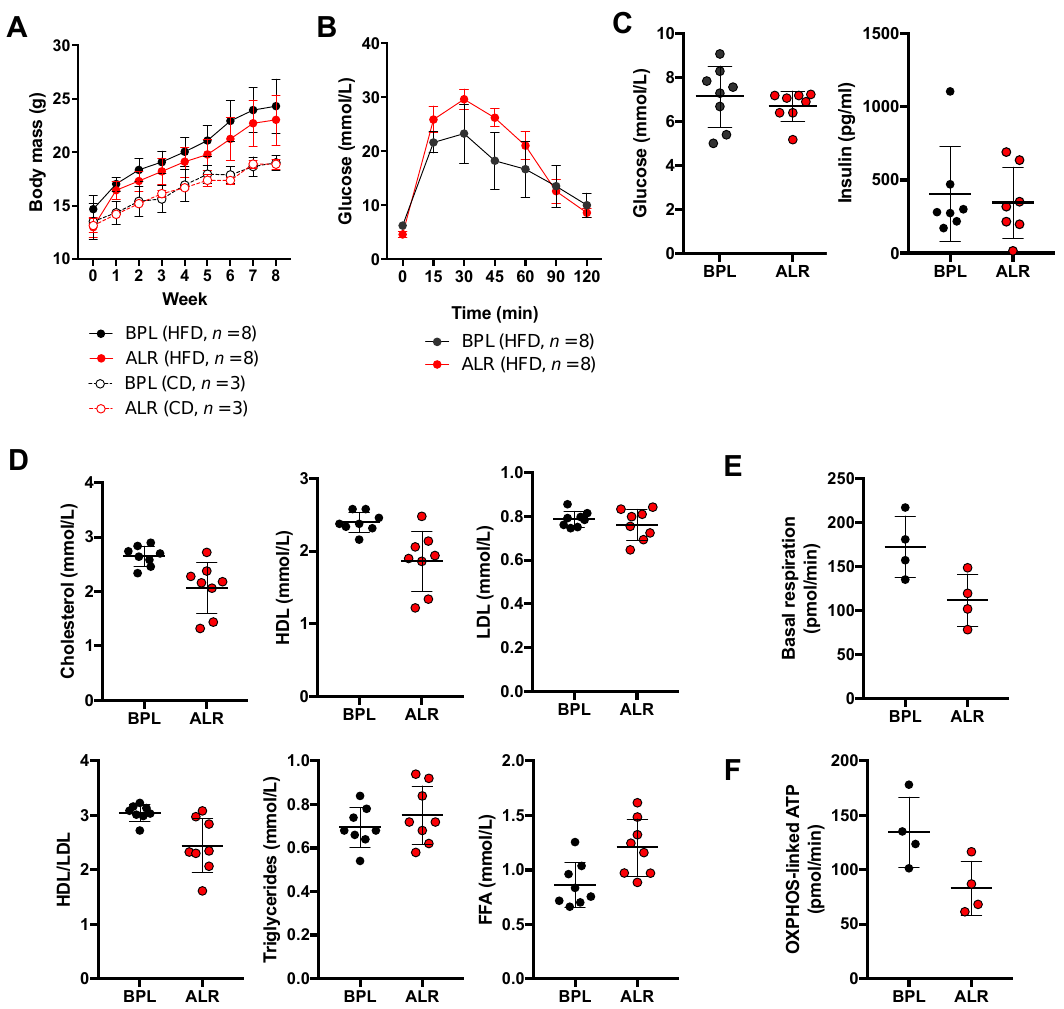
Figure 5. The B6-mt ALR mice exhibited higher susceptibility to diet-induced glucose intolerance. ( A ). Female mice were fed with high fat diet (60 kJ% fat, n = 8/strain) or control diet (13 kJ% fat, n = 3/strain) for 8 weeks starting at 4 weeks of age. Body mass and weight gain due to the high fat diet were unaltered between strains. HFD: high fat diet; CD: control diet. BPL: B6-mt BPL ; ALR: B6-mt ALR . ( B ) Intraperitoneal glucose tolerance test was conducted after 8 weeks of feeding. B6-mt ALR mice exhibited impaired glucose tolerance compared to B6-mt BPL . Main effect of strains: descriptive p = 0.0238, interaction between strains and time: descriptive p <0.0001, two-way nonparametric analysis of variance. ( C ) Levels of glucose and insulin were determined in morning-fasted serum samples obtained HFD-fed B6-mt BPL and B6-mt ALR mice. ( D ) Lipid profiles were measured in the same samples as tested in c . Cholesterol, descriptive p = 0.0057; HDL, descriptive p = 0.0038; HDL/LDL, descriptive p = 0.0054; FFA, descriptive p = 0.0115; t test. HDL: high-density lipoprotein; LDL: low-density lipoprotein; FFA: free fatty acids. ( E , F ) Primary hepatocyte prepared from mice fed with HFD demonstrated the levels of basal respiration and OXPHSO-linked ATP production were lower in hepatocytes from B6-mt ALR than those from B6-mt BPL . Descriptive p = 0.0389 ( E ), descriptive p = 0.0446 ( F ), t- test.